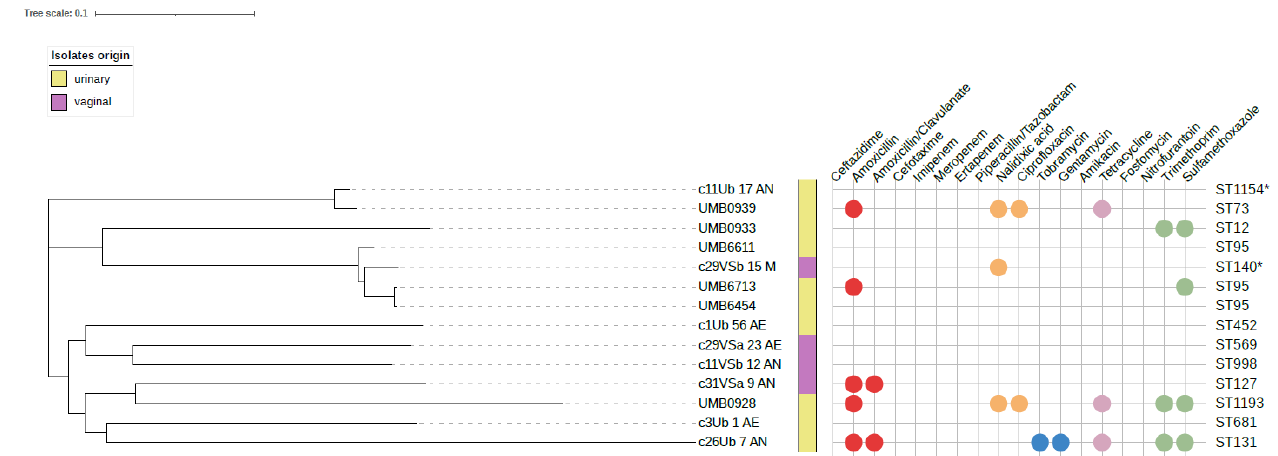
Figure 2. Phylogenetic tree representing core genome SNPs alignment of 14 urogenital E. coli strains isolated from asymptomatic women (8 from our study and 6 from Garretto et al.). The alignment was performed using E. coli strain UTI89 as a reference. The tree is unrooted. Colored balls represent the resistance phenotype/genotype to a given antibiotic (colors by antibiotic class). Resistance of the strains originated from this study was characterized by phenotypic and genotypic methods, while strains from Garretto et al. were characterized genotypically. Single locus variants (SLV) are represented with an asterisk (see Table 1).